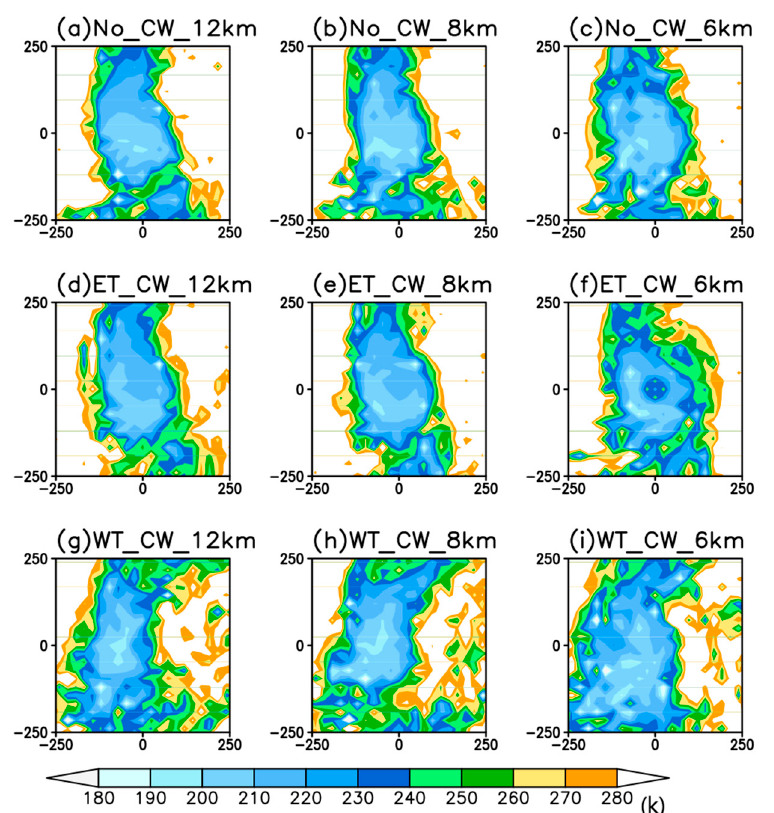
Figure 11. The 12-h averaged CTT in the inner region of TC (250 km × 250 km) over periods (48~60 h) in ( a ) No_CW_12 km, ( b ) No_CW_8 km, ( c ) No_CW_6 km, ( d ) ET_CW_12 km, ( e ) ET_CW_8 km, ( f ) ET_CW_6 km, ( g ) WT_CW_12 km, ( h ) WT_CW_8 km and ( i ) WT_CW_6 km experiment of Typhoon